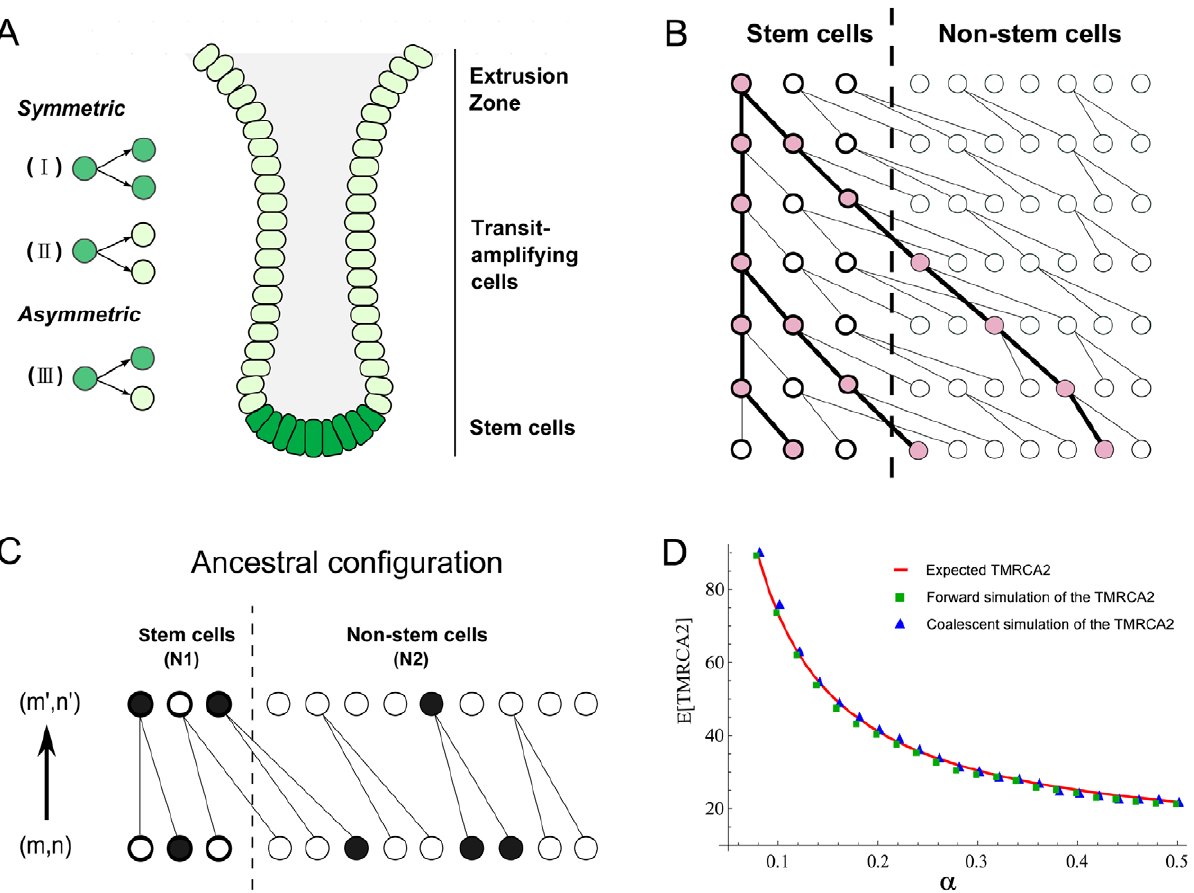
Figure 1. Anatomy of intestinal crypts and coalescent processes for the two-deme model. (A) Anatomical structure of the intestinal crypt. The dark green cells represent stem cells and light green cells are transit-amplifying cells. There are three types of stem cells divisions (I, II and III, see main text). (B) A cartoon illustration of a coalescent process in the two deme model. One cell from stem cell deme and two cells from the transit- amplifying cell deme were sampled. Their ancestral relationship is depicted as the gene tree connecting their ancestors. (C) The state transition for the Markov Chain in one step. The current state of the chain is (m,n) and the state in the previous generation is (m 9 ,n 9 ). In the example here, (m,n)=(1,3) and (m 9 ,n 9 )=(2,1). (D) The expected time to the most recent common ancestor for two lineages (denoted as TMRCA2) was calculated using three different approaches. The solid line is calculated using a first-step analysis of the Markov Chain. Blue squares are the results from the forward simulation and triangles are from the direct simulation following the Markov Chain.